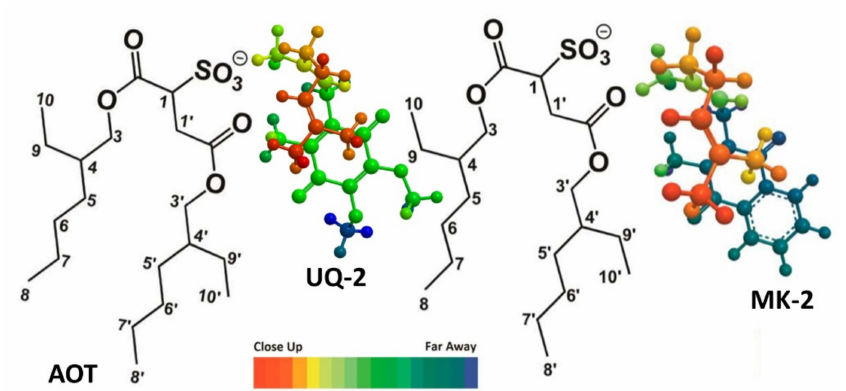
Figure 13. Comparison of the location of UQ-2 and MK-2 in AOT reverse micelles. AOT protons labeled provided. The color spectrum indicated relative depth when viewed from above. This figure was originally published in Ref. [41] and is licensed under CC-BY 4.0.